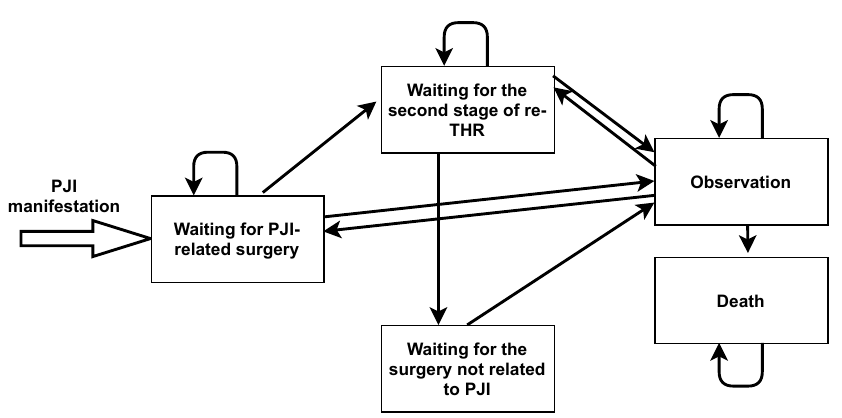
Figure 2. Markov model states and